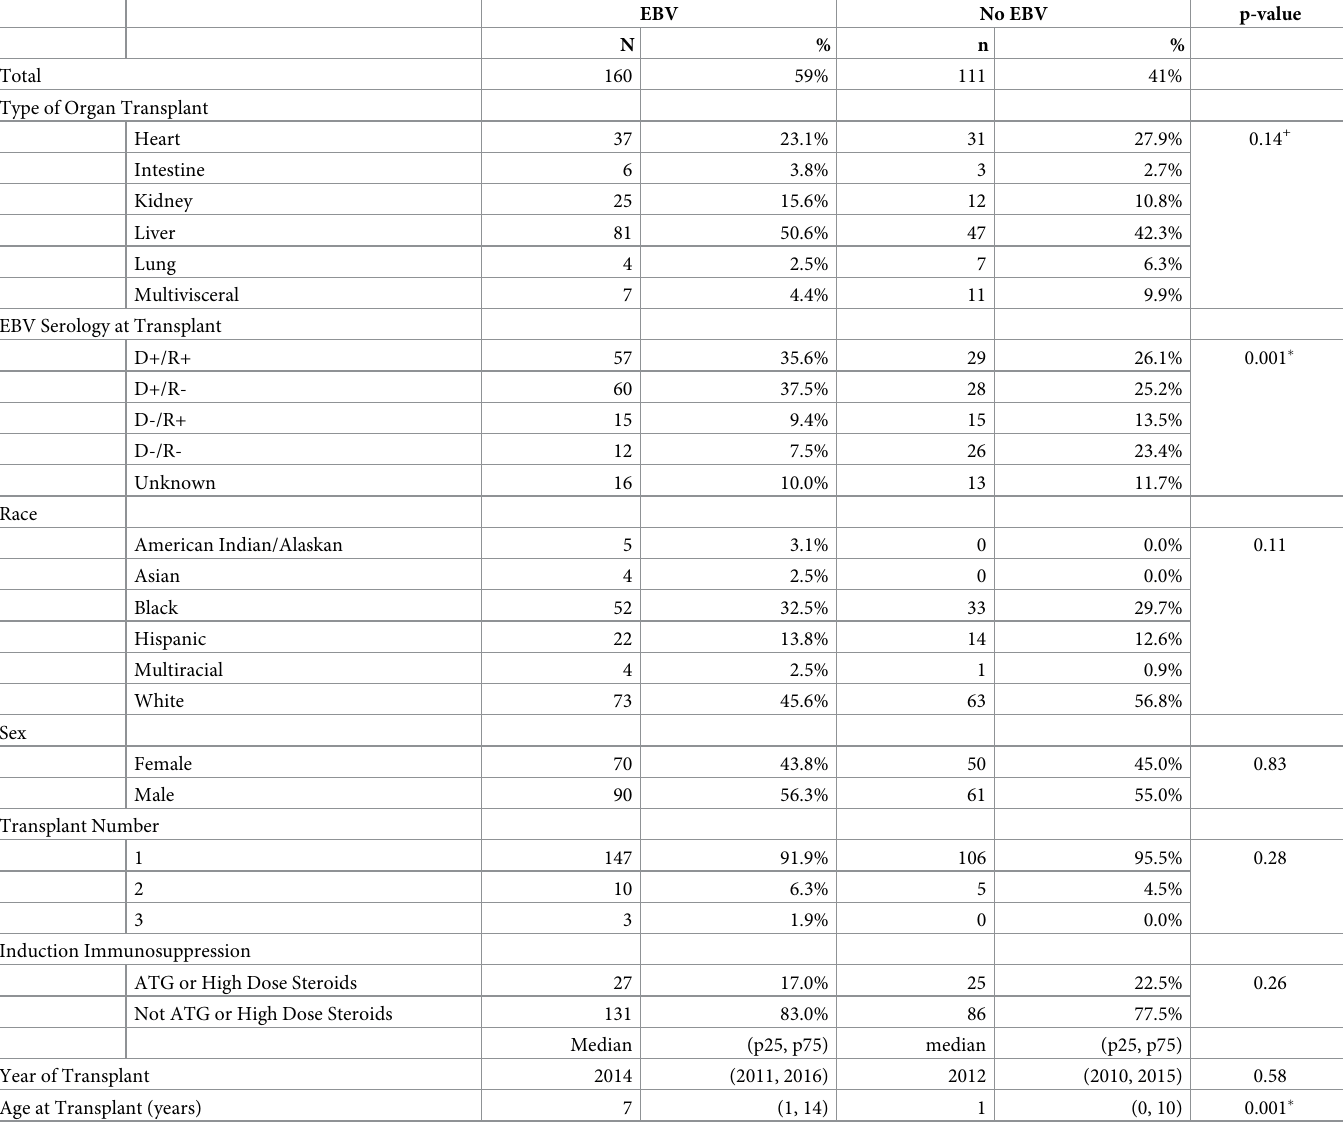
Table 3. The characteristics of children who had any EBV DNAemia after transplant are compared to those who did not have any EBV